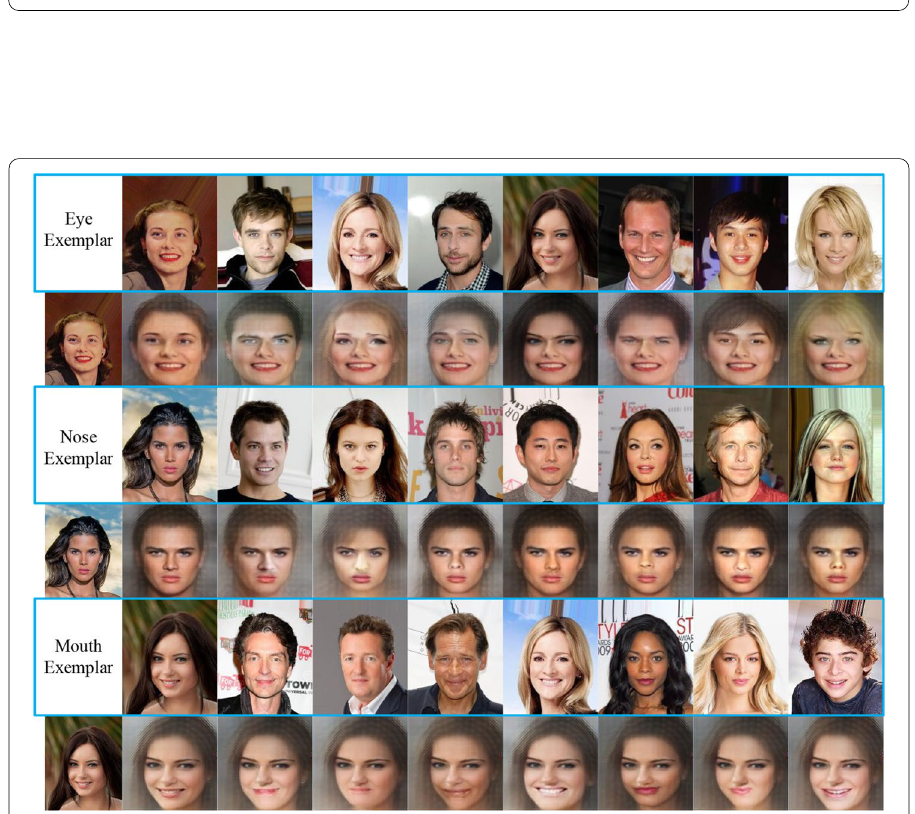
Fig. 6 Face editing by replacing parts of a person’s face with someone else’s. Rows 1, 3 and 5 are examples of eyes, nose and mouth, respectively. Rows 2, 4 and 6 are the synthetic results after replacing this facial part, where the first image is the reconstruction of the input